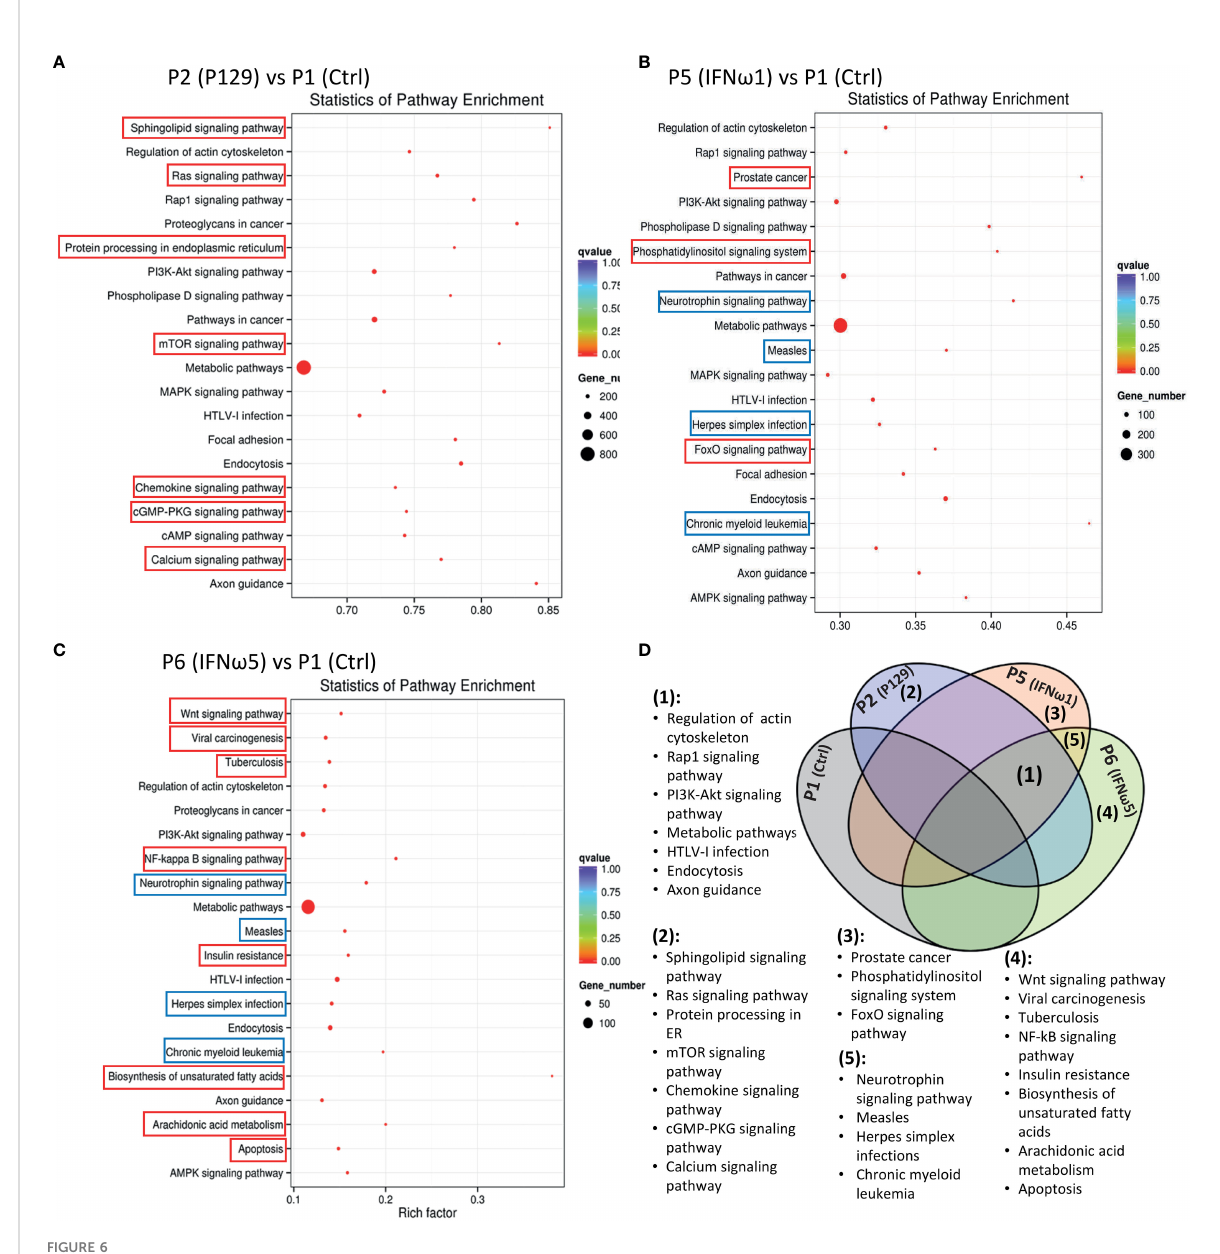
FIGURE 6 Scatter plots of pathway enrichment analysis of genes targeted by signi fi cantly differentially expressed miRNAs between the control P1 and the P129-infected (A) or treated with IFN- w 1 (B) or IFN- w 5 (C) . Pathway enrichment analysis was conducted based on the Kyoto Encyclopedia of Genes and Genomes (KEGG) database. The Y-Axis lists signi fi cantly enriched pathways and X-Axis shows the enrichment factor. Dot size represents the number of miRNA-targeted genes and the color indicates the scale of the q-value. Pathways framed indicated unique pathways enriched in each compared pair only (Red frame) or some compared pairs (Blue frame). (D) Venn diagram to summarize pathways commonly (1) unframed pathways in (A – C) or uniquely (2-5). Framed pathways in (A – C) enriched in the different